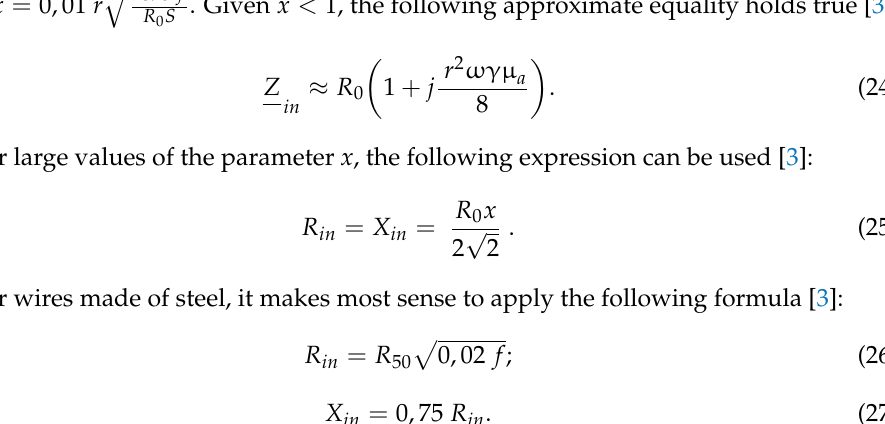
Figure 5. Original circuit of the power transmission line.